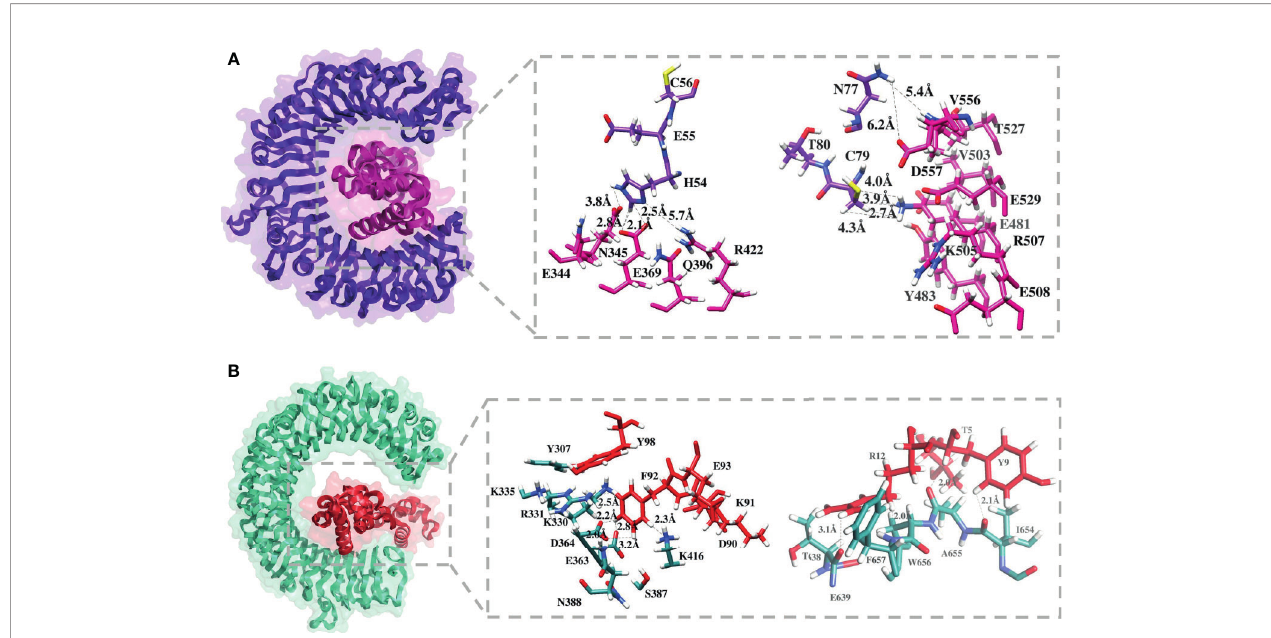
FIGURE 6 | Molecular docking between MEV and TLR receptors. (A) Docked conformation and residues interaction map of MEV (shown in pink) to TLR2 (shown in purple), and (B) Docked conformation and residues interaction map of MEV (shown in red) to TLR3 (shown in cyan